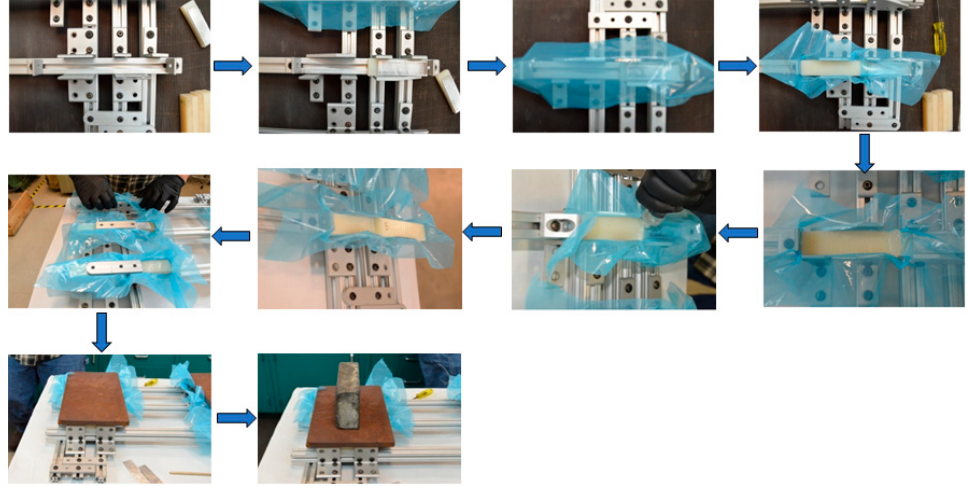
Figure 4. The 80/20 aluminum fixture showing images of the procedure making single-joint lap